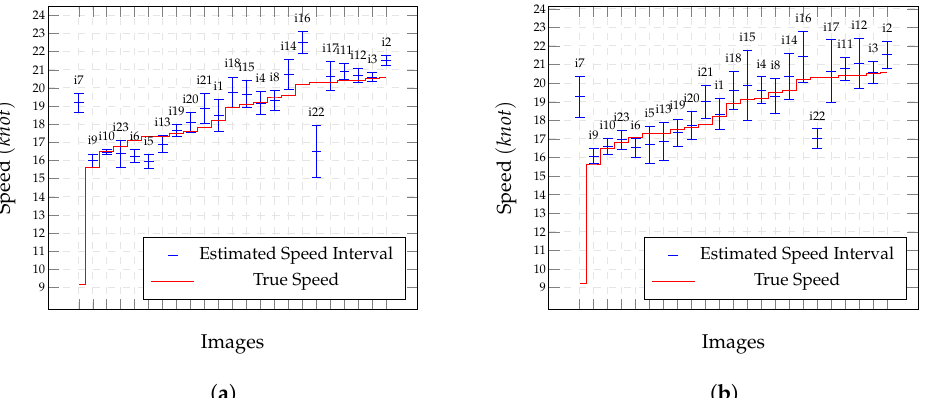
Figure 8. Confidence intervals ( γ = 99.8%) that were computed using ( a ) sampling and ( b ) first-order error propagation. Images sorted by vessel